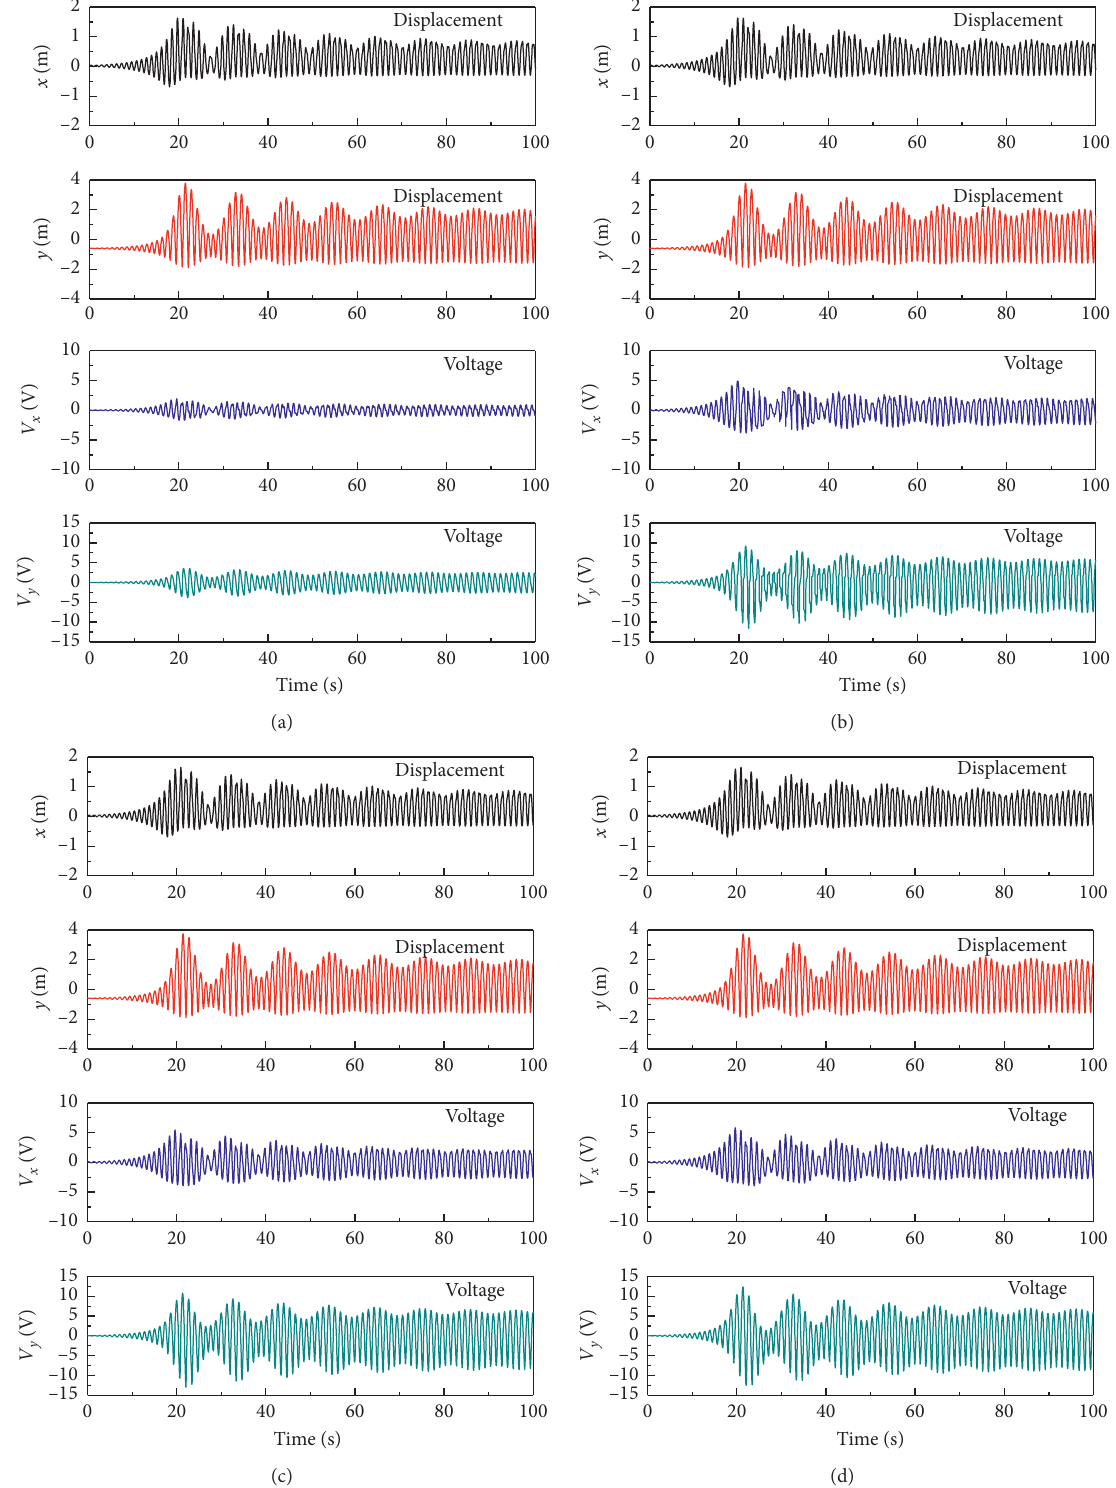
Figure 26: Considering separation, the displacement and output voltage of the friction system when the external electrical resistance is R � 10000 Ω (a), R � 50000 Ω (b), R � 100000 Ω (c), and R � 200000 Ω